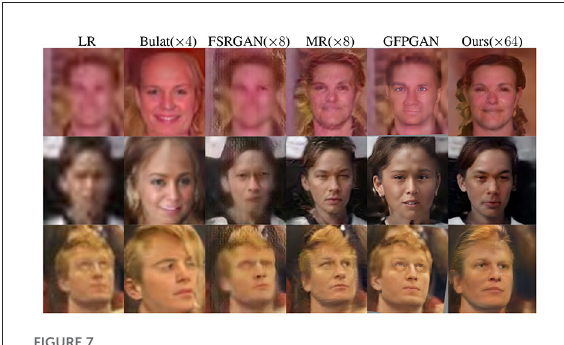
FIGURE7 Comparison of FSR results on the Widerface dataset between ours, FSRGAN (Chen et al., 2018), Bulat’s method (Bulat et al., 2018), and GFPGAN (Wang et al., 2021) (no GT is available).